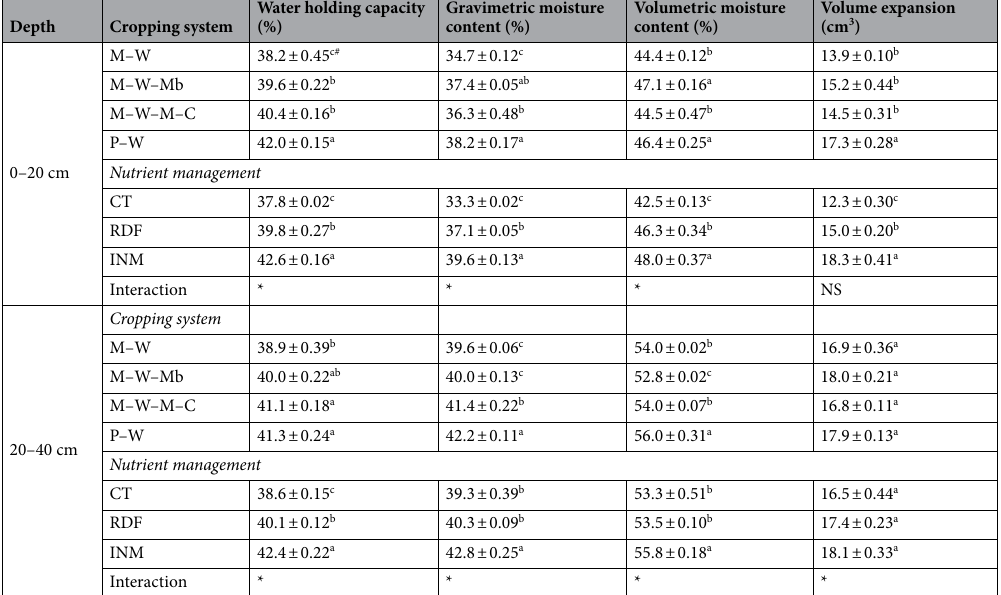
Table 2. Impact of pulses and organic amendments on soil constituents (mass–volume relationship). # Lowercase letters (a–c) after values (mean ± standard error) delineates significant difference at p ≤ 0.05 using Tukey’s honest significance test; *denotes interaction is significant; NS =